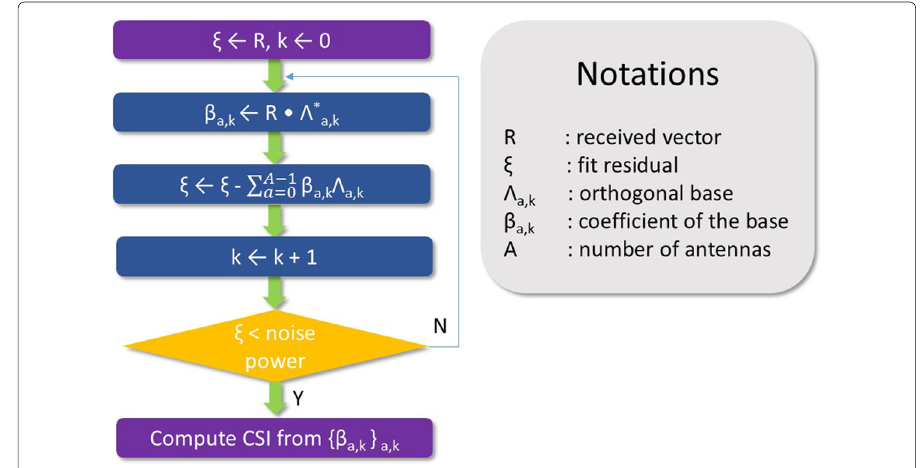
Fig. 1 The flowchart of